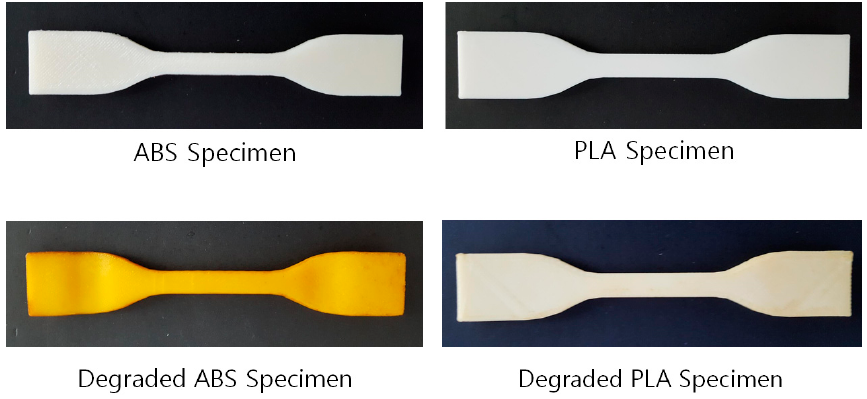
Figure 7. Activation functions.